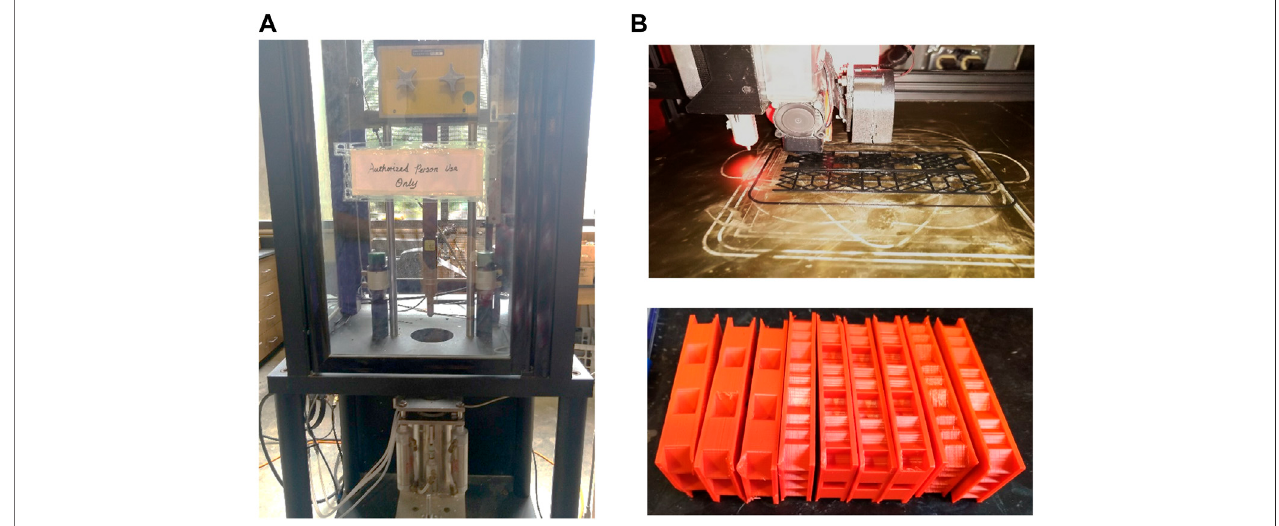
FIGURE 6 | (A) Instron Dynatup impact tester, (B) Extrusion based 3D printer (upper right) , Additively manufactured of sandwich structures (lower right) .